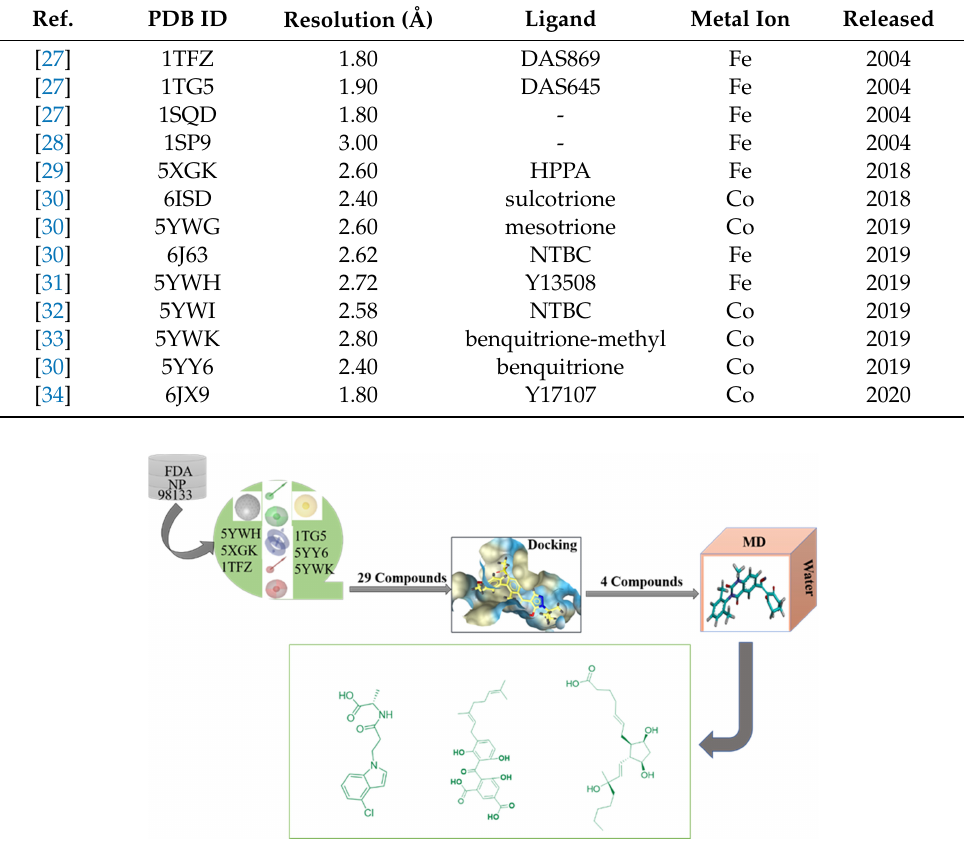
Table 1. Structural information of published Arabidopsis thaliana HPPD ( At HPPD) crystals. Ref.